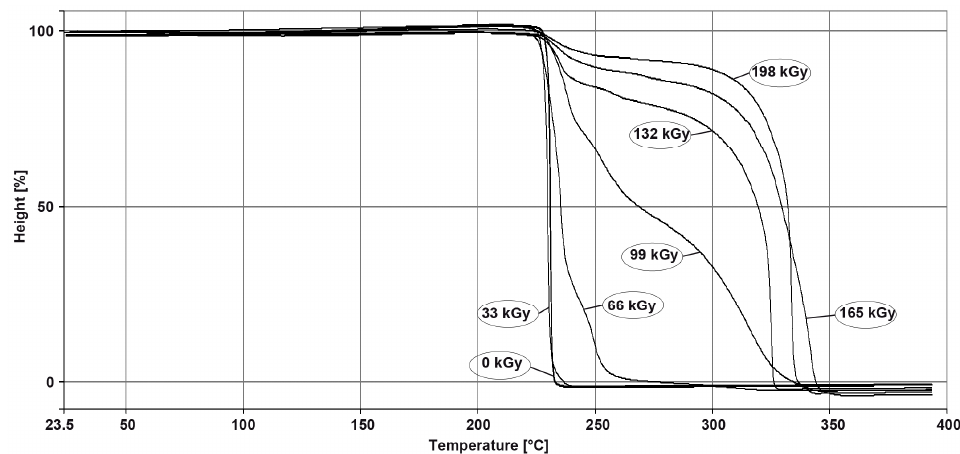
Figure 17. TMA—Technical polymers (PBT).